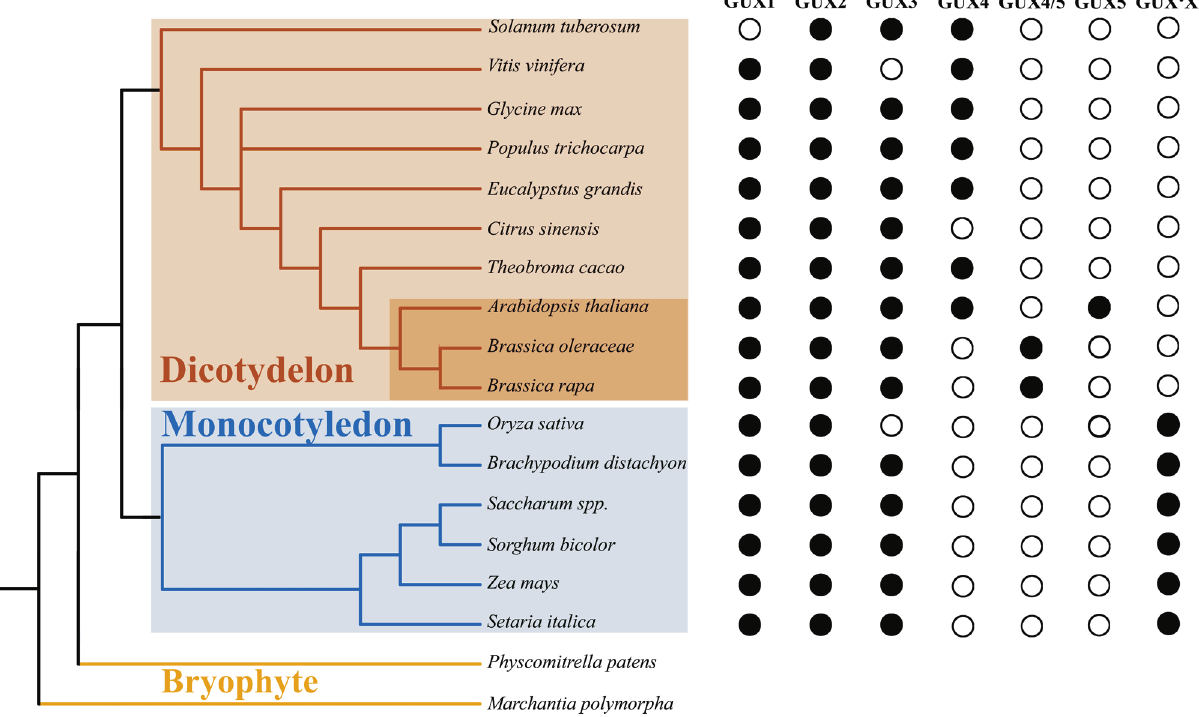
Figure 2 - Cladogram representing the relationship among all the species surveyed in this study. Black circles represent the presence of gene(s) within a GUX clade and white circles represent the absence of genes within a clade. The distances do not correspond to phylogenetic distances. Orange box high- lights dicotyledonous clade. Dark orange box highlights Brassicaceae family. Blue box highlights the monocotyledonous clade. Yellow lines highlight bryophytes as the